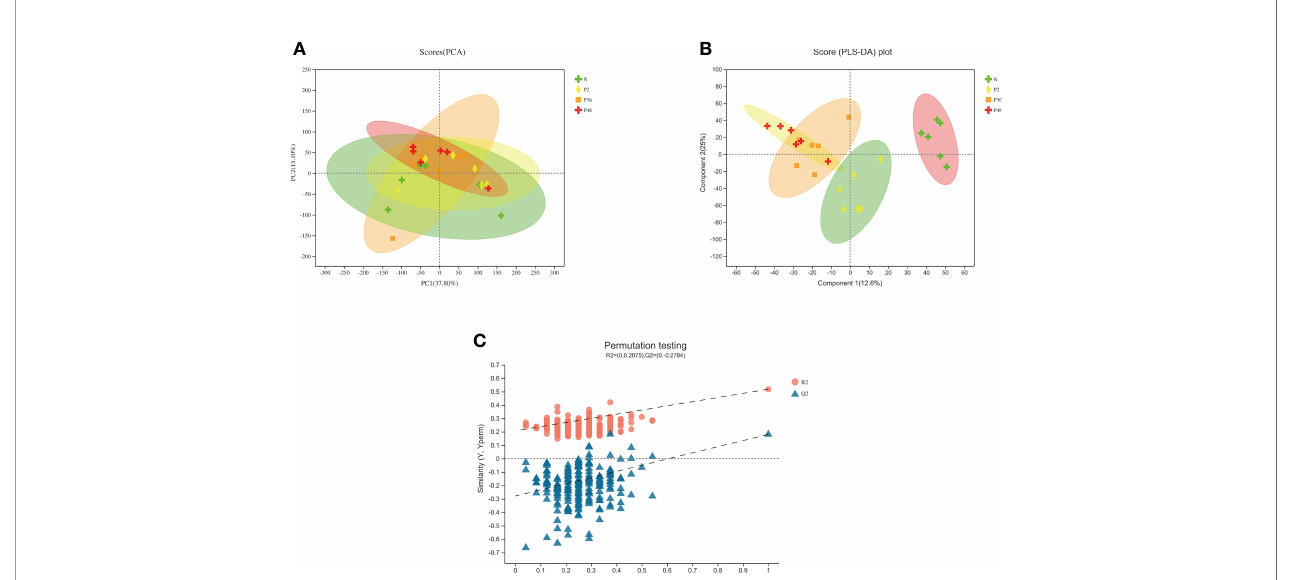
FIGURE 5 | Quality analysis chart of metabolomics data of the L. vannamei hepatopancreas at different times after WSSV challenge. (A) Principal component analysis (PCA) score chart. The parameters of the fi rst and second principal components R 2 X (cum) were 0.378 and 0.53, respectively. (B) Partial least-squares discriminant analysis (PLS-DA) score plot. (C) A total of 200 permutation tests on PLS-DA were performed to obtain model veri fi cation of PLS-DA. The parameters of the R2 and Q2 scores were 0.2075 and − 0.2784, respectively.